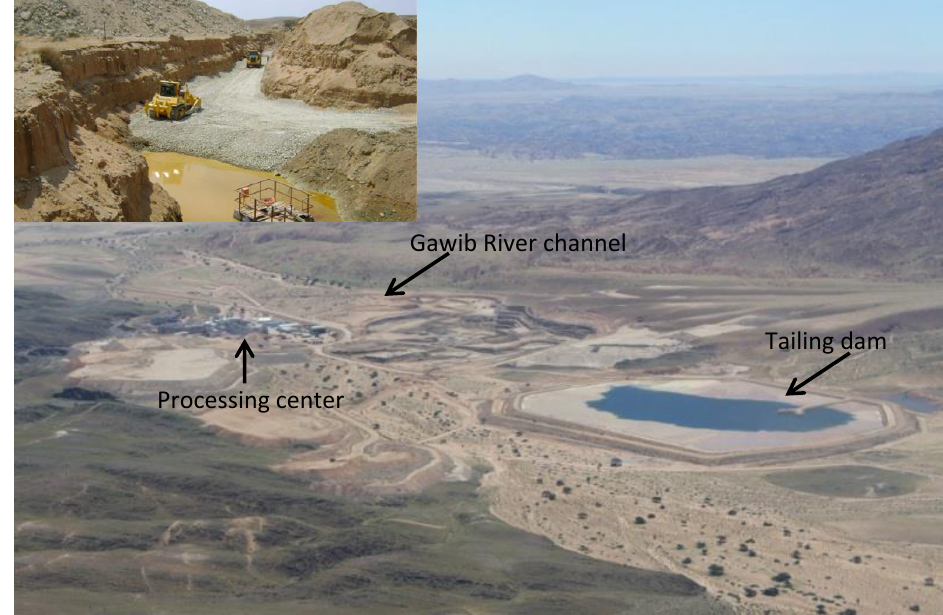
Figure 2. Uranium mine tailing at the Langerheinrich mine overlying the Gawib River channel with an inset showing seepage from the mining operations.